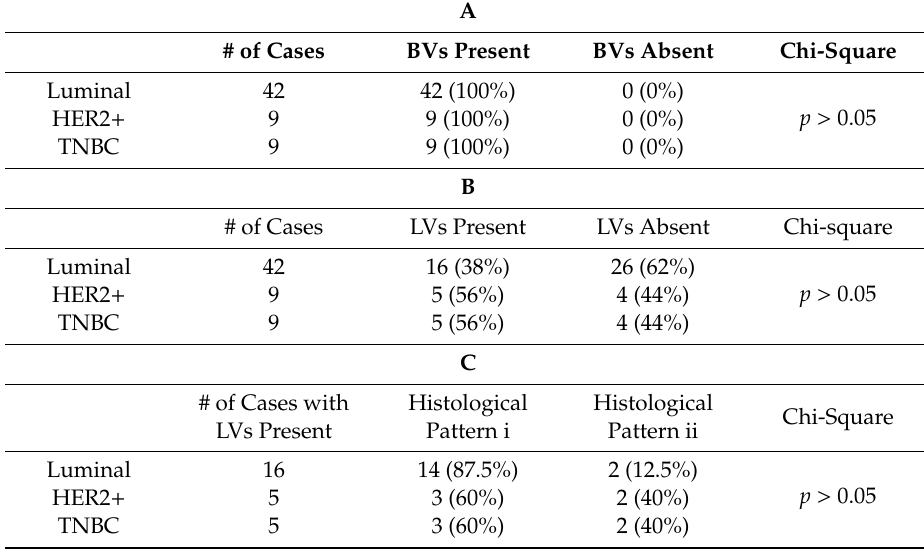
Table 1C). The detailed analysis of the presence or absence of BVs and LVs, their location within NDMC and DMC and relationship to breast cancer subtype is shown in Table 2. Table 1. Association of LVs and BVs with breast cancer subtypes in a patient